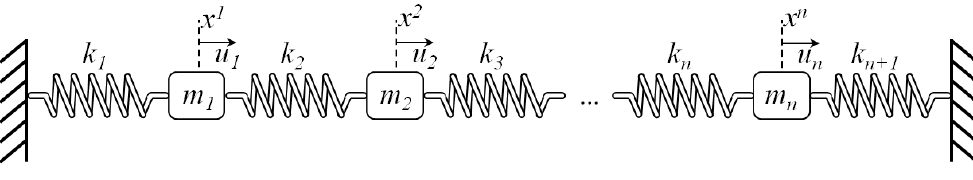
Figure 1. The n -coupled mass-spring